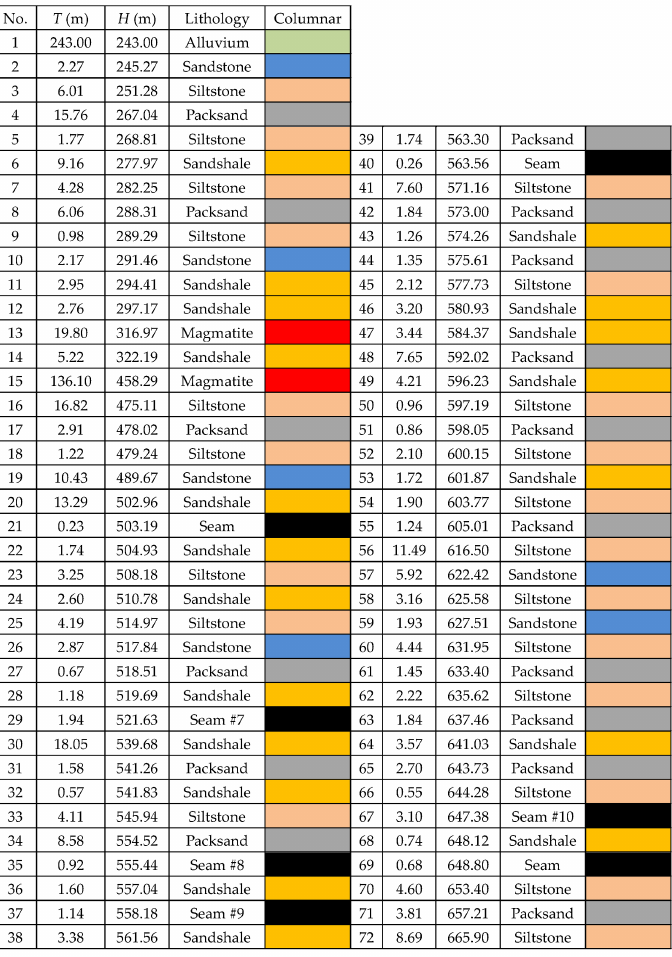
Figure 6. Columnar section of drill hole 06-1. T is the thickness of each stratum. H is the distance from each stratum to